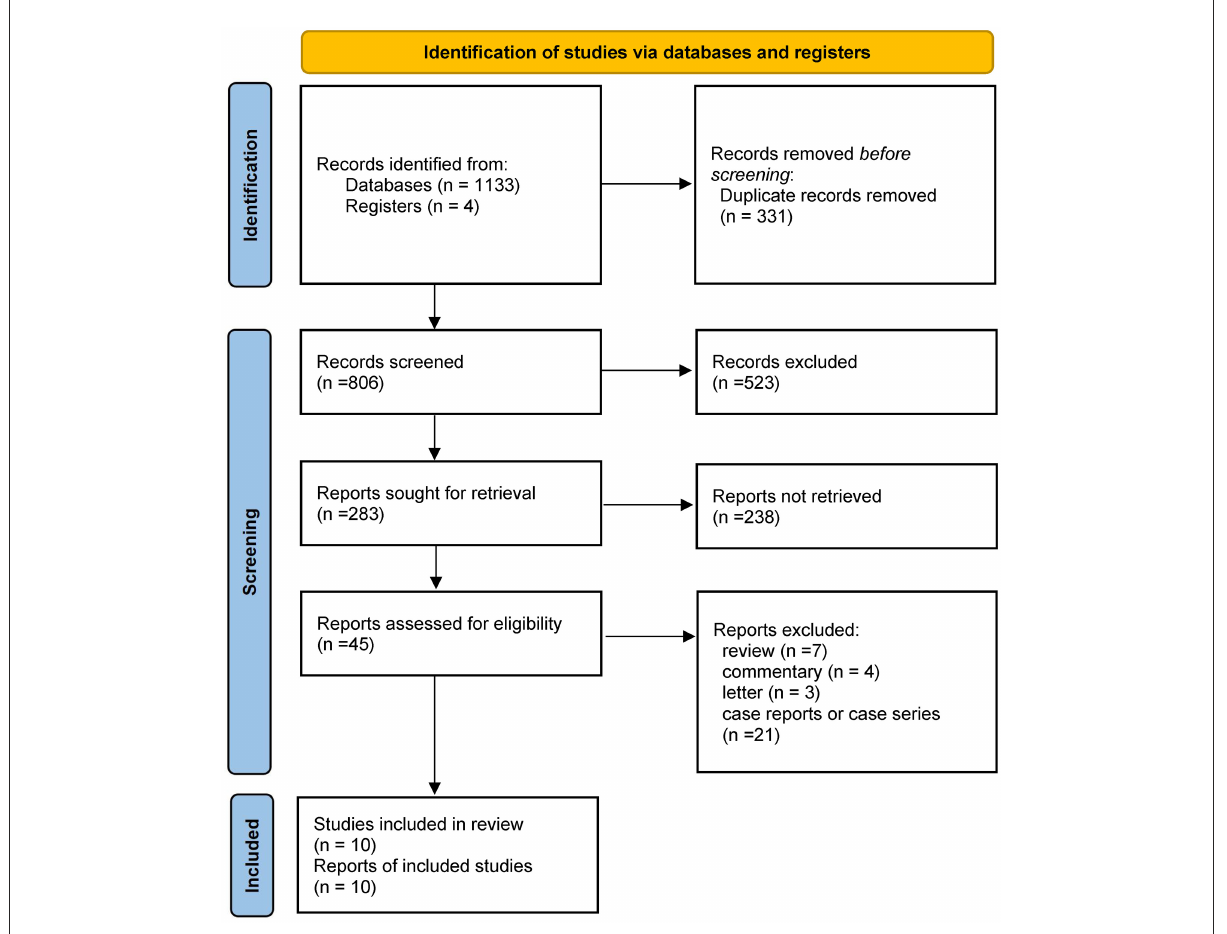
FIGURE1 PRISMA flow diagram of study